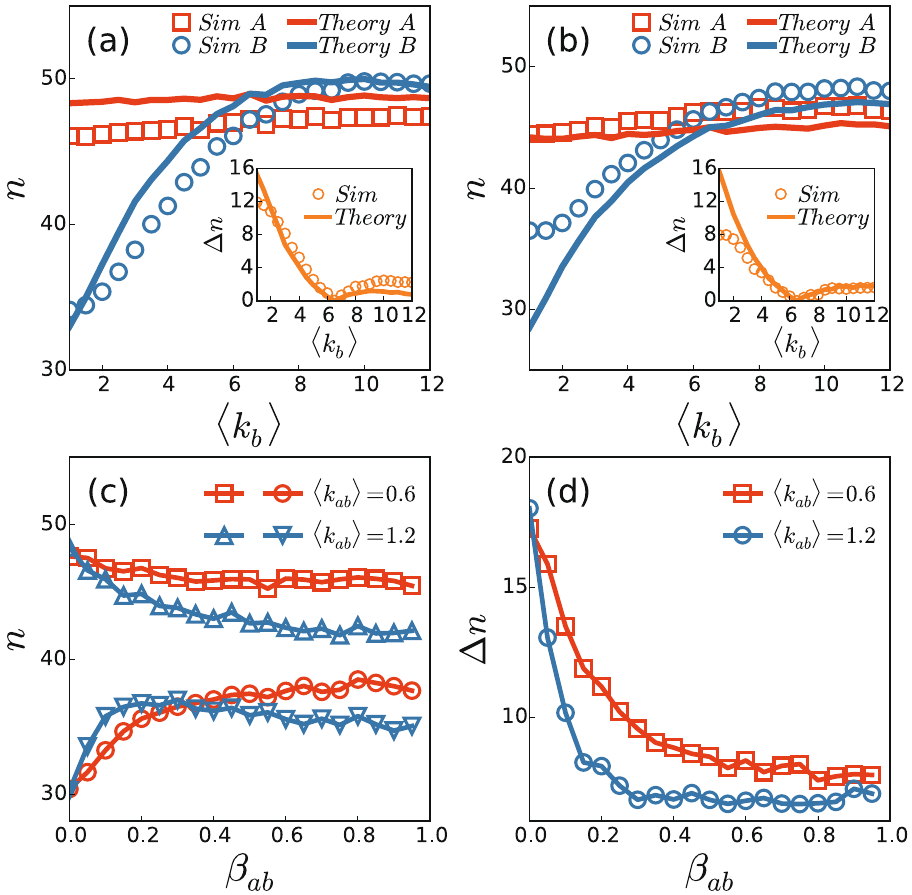
Figure 4. ( a ) and ( b ) Dependence of n on the average degree 〈 k b 〉 of network  for β ab = 0.09 and 0.3, respectively, where the average degree of network  is fixed as 〈 k a 〉 = 6.5, 〈 k ab 〉 = 1.0, and the insets show the dependence of ∆ = − n n n ( ) ( ) A B on 〈 k b 〉 . The solid lines represent the theoretical results from Eqs (6) and (7). ( c ) Dependence of n on β ab with 〈 k a 〉 = 6.5 and 〈 k b 〉 = 1.5 where the “squares” and “circles” represent the case of 〈 k ab 〉 = 0.6 for the networks and A B , respectively, and the “up triangles” and “down triangles” represent the case of 〈 k ab 〉 = 1.2 for the networks and A B , respectively. ( d ) Dependence of Δ n on β ab with 〈 k a 〉 = 6.5 and 〈 k b 〉 = 1.5 where the “squares” and “circles” represent the cases of 〈 k ab 〉 = 0.6 and 1.2, respectively. The other parameters are set as  β ∼ . . t (